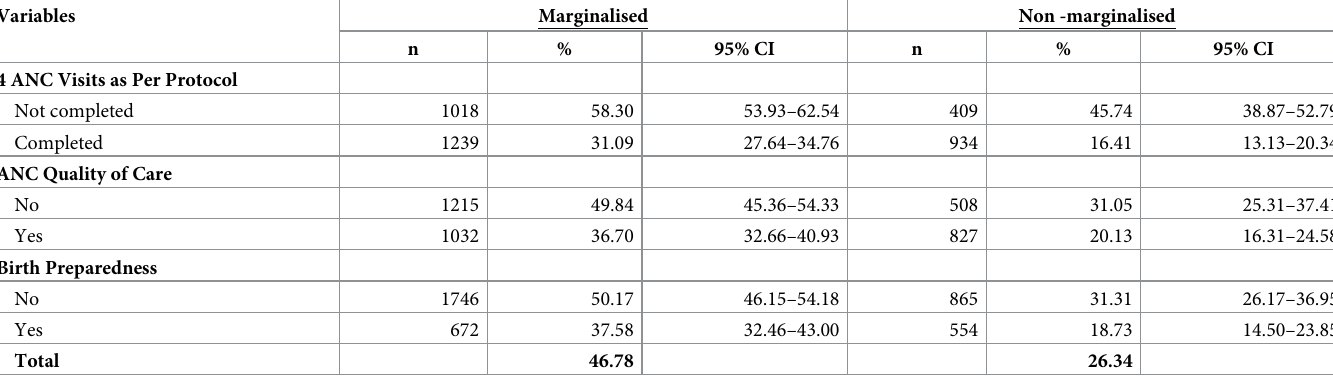
Table 5. Percentage of marginalised and non- marginalised women delivering their last child at home, according to ANC and birth preparedness variables. Variables